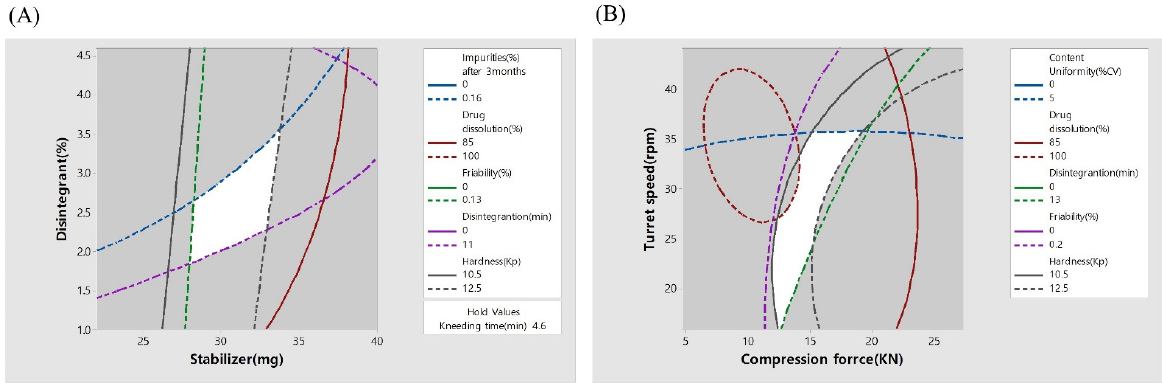
Figure 5. Design space of the wet granulations ( A ) and tablet compression process ( B ). To set the design space of the two processes, the range of hardness in the contour plots was set to 10.5–12.5 Kp. The range of the friability was set up such that the maximum friability was not more than 0.13%. The range of the disintegration time was set up such that disintegration of the TA tablets was not more than 11 min. The range of drug disso- lution was set such that the maximum drug dissolution after 30 min was not less than 85%. The range of total impurities was set such that the maximum impurities after 3 months was not more than 0.16%. The range of content uniformity (%) was set such that the maximum content uniformity was not more than 5.0%. As mentioned above, the drug dissolution value after 30 min was the dissolution rate of telmisartan in the design space. Dissolution tests were performed for both telmisartan potassium and amlodipine besylate. However, amlodipine showed an immediate release pattern because of post-mixing, whereas telmisartan showed a dissolution delay pattern by various excipients. Therefore, the dissolution rate of telmisartan was considered to be the more critical factor. Based on the area of the design space, it was possible to determine the space area that satisfied all the conditions. As a result, the single-layered TA tablets were prepared in the design space that satisfied all the conditions. 3.5. Pharmacokinetics The in vivo pharmacokinetic properties of the single-layered TA tablets, prepared by design space, after oral administration in beagle dogs ( n = 12) were evaluated. The 80/5 mg of TA tablet concentrations were assessed from the plasma concentration-time profiles of Twynstar ® and the single-layered TA tablets at a dose of 8.0 mg/kg are indicated in Figure 6.